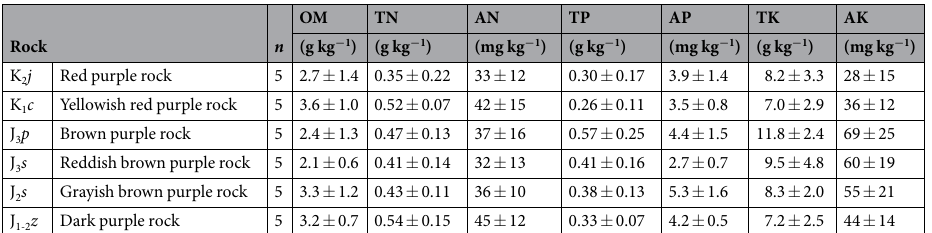
Table 4. Organic matter and nutrient contents of the purple rocks. Note: OM, organic matter; TN, total nitrogen; AN, available nitrogen; TP, total phosphorus; AP, available phosphorus; TK, total potassium; AK, available